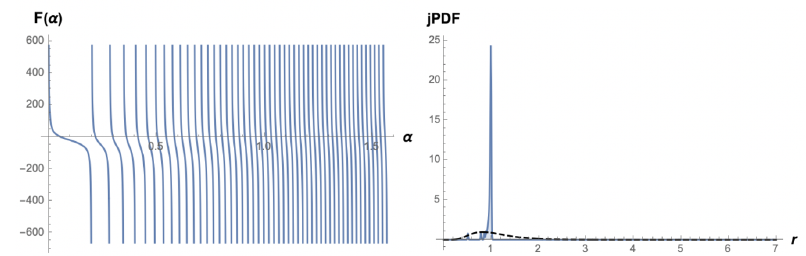
Figure 5 . The logarithmic derivative of the decay amplitude and the joint probability distribution both relative to the microstate of N = 100 with only one harmonic. The dashed line is the